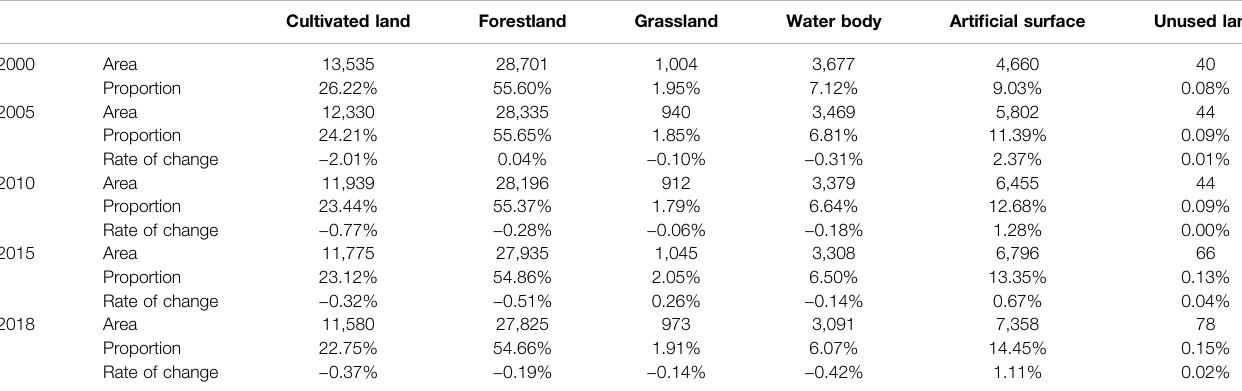
TABLE 1 | Statistics on area and change of land in the Pearl River Delta from 2000 to 2018 ( km 2